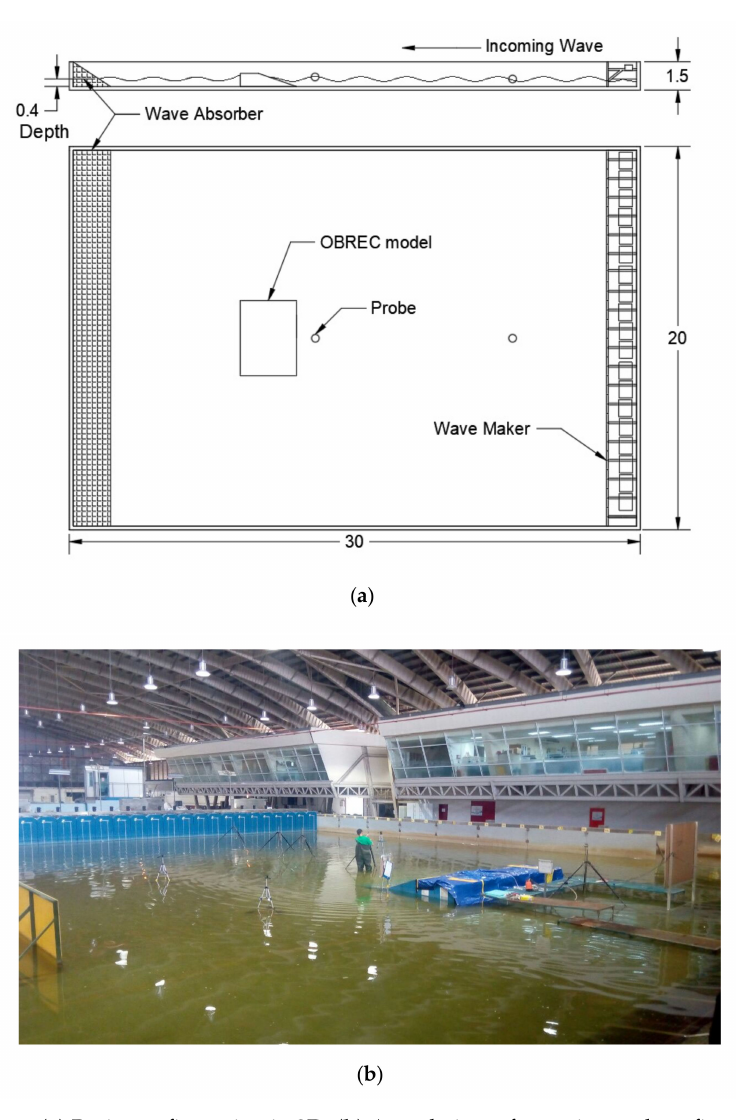
Figure 6. ( a ) Basin configuration in 2D. ( b ) Actual view of experimental configuration.